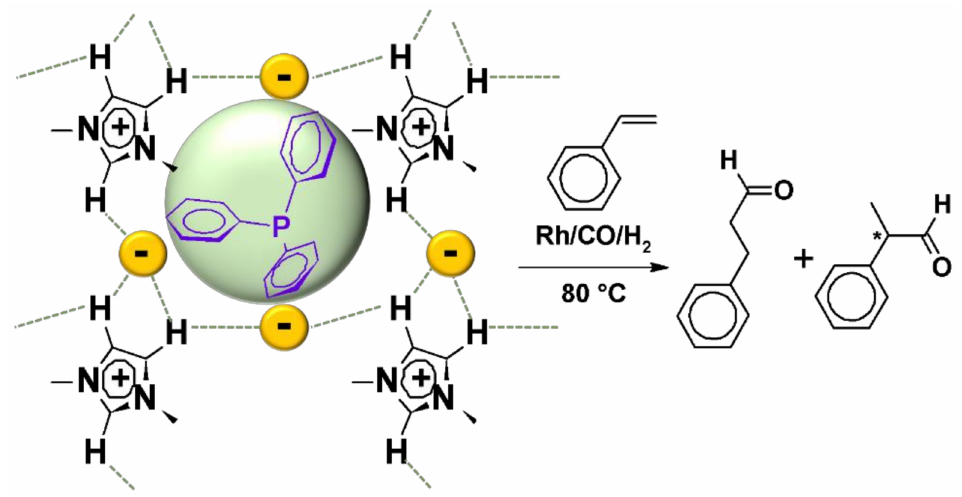
Figure 43. The inclusion of a triphenylphosphine ligand in the 1-methyl-3-[(S)-2- methylbutyl]imidazolium triflate lattice and its application in the biphasic hydroformylation of styrene